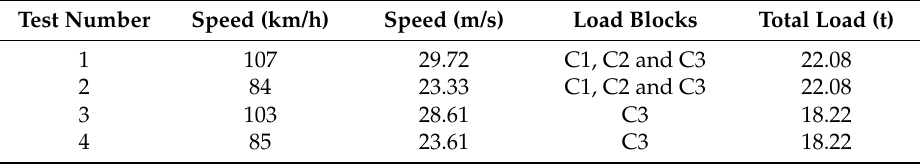
Table 2. Considered load-speed combinations.